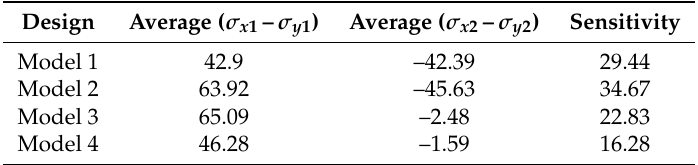
Table 6. Comparison of differential stress and sensitivity for four design